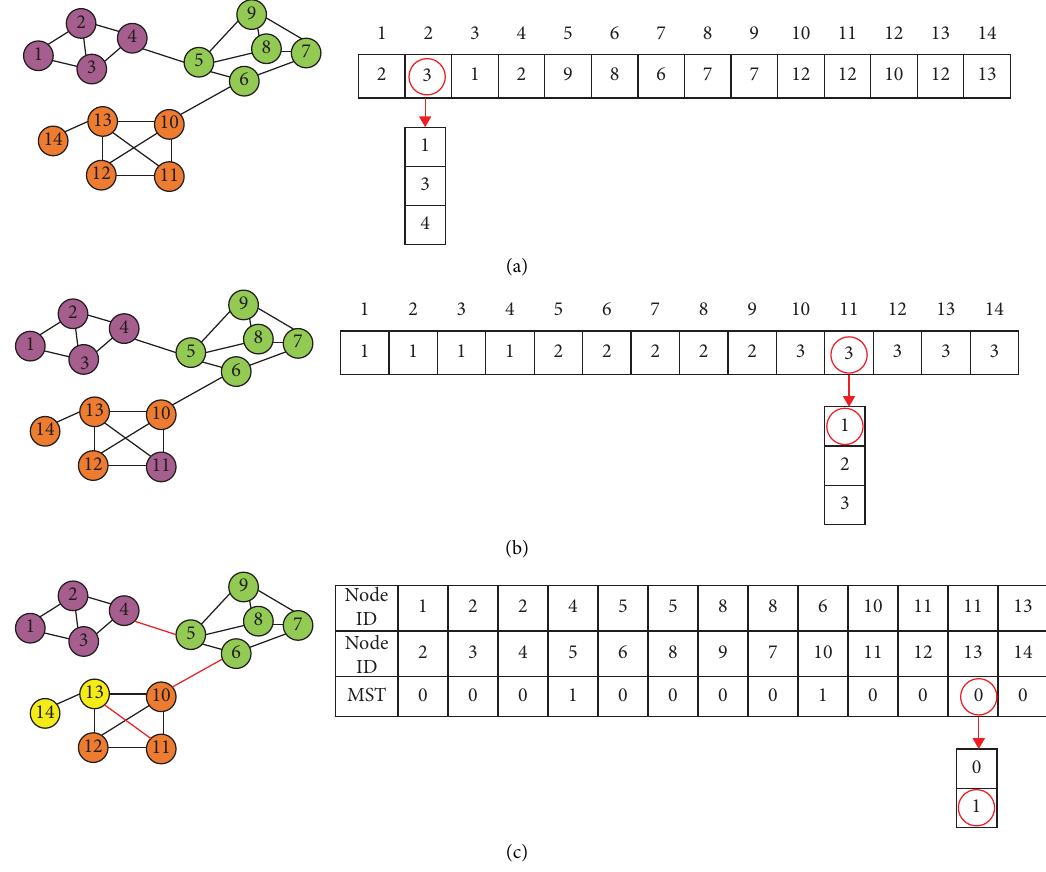
Figure 1: Comparison of diferent representation schemes and their corresponding graphs. (a) An individual created by the locus-based method. As it can be seen, using this method might cause meaningless mutations, (b) an individual created by the solution-vector method. Using this method might result in separated communities, and (c) MST-based representation. Tis method reduces the domain of each element to binary and avoids meaningless mutations and separated